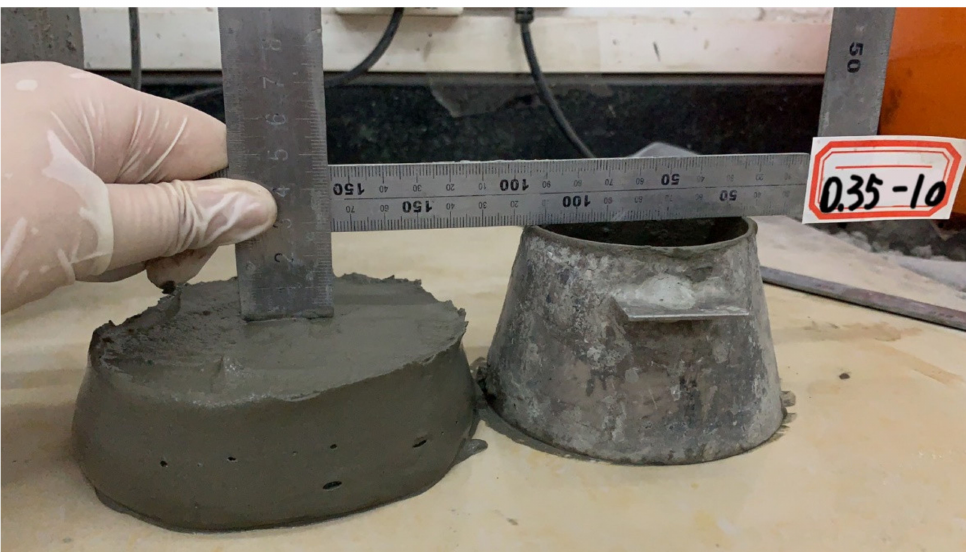
Figure 4. Photograph of mini slump cone